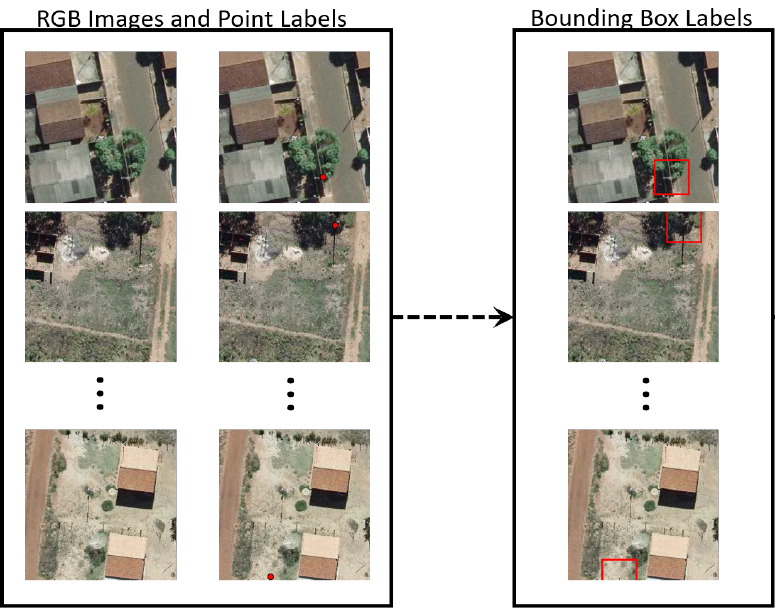
Figure 3. Steps of the pole detection